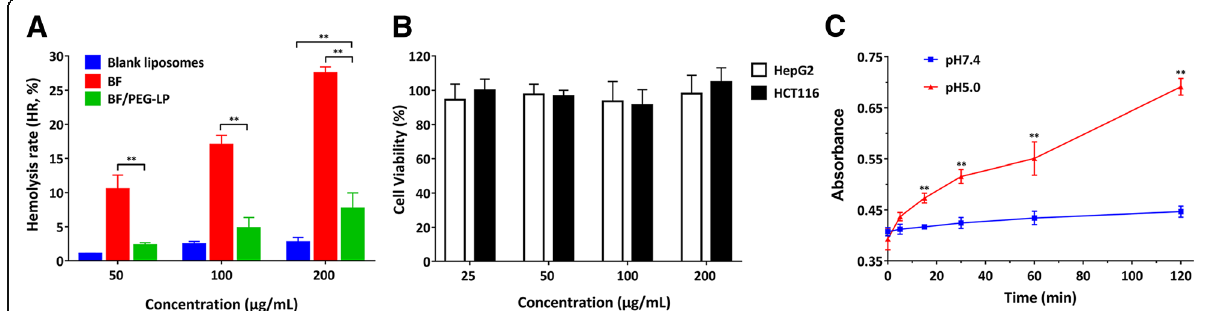
Fig. 1 Physical and chemical properties of BF/PEG-LP. a Red blood cell hemolysis rate of blank liposomes, BF, and BF/PEG-LP. Data are presented as (cid:2) x ± s ( n = 3). ** P < 0.01 vs . BF/PEG-LP group at the same concentration. b Cytotoxicity of blank liposomes in HepG2 and HCT116 cells. Data are presented as (cid:2) x ± s ( n = 6). c Stability of BF/PEG-LP in different pH conditions. Data are presented as (cid:2) x ± s ( n = 6). ** P < 0.01 vs . pH 7.4 group at